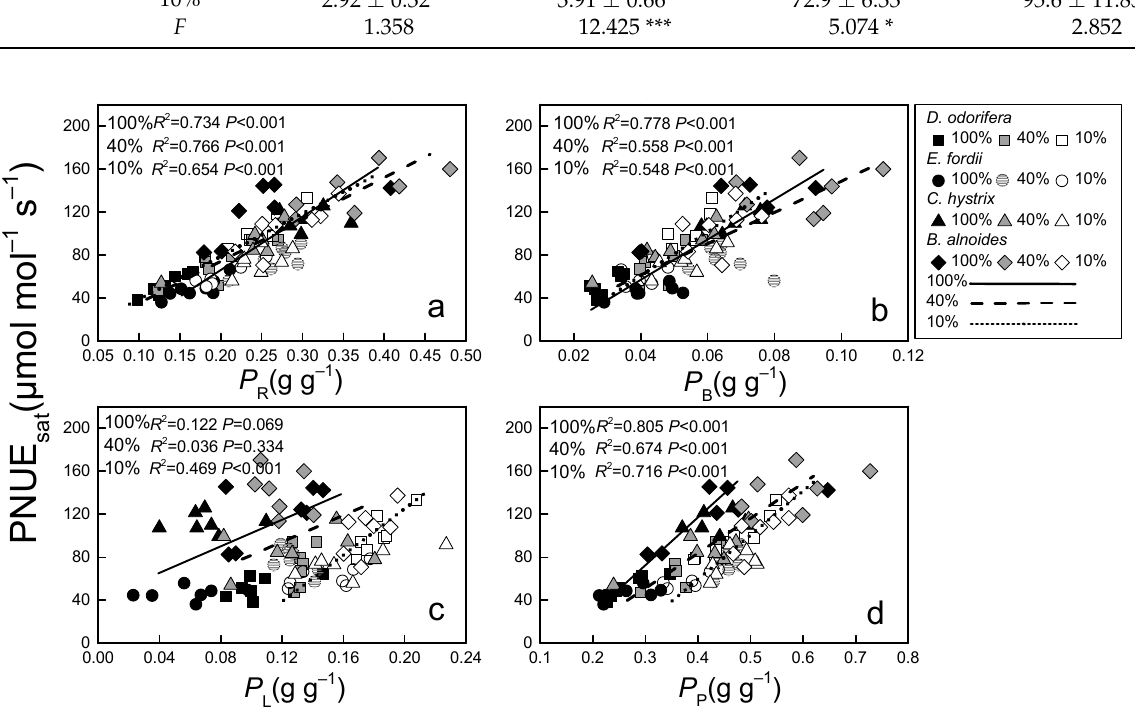
Figure 1. Relationship between PPFD-saturated photosynthetic N use efficiency (PNUE sat ) and ( a ) N allocation proportion of Rubisco ( P R ), ( b ) bioenergetics ( P B ), ( c ) light-harvesting components ( P L ) and ( d ) photosynthetic system ( P P ) in Dalbergia odorifera , Erythrophleum fordii, Betula alnoides , and Castanopsis hystrix grown under three different irradiance treatments. The determination coefficient ( R 2 ) and p -value are shown.